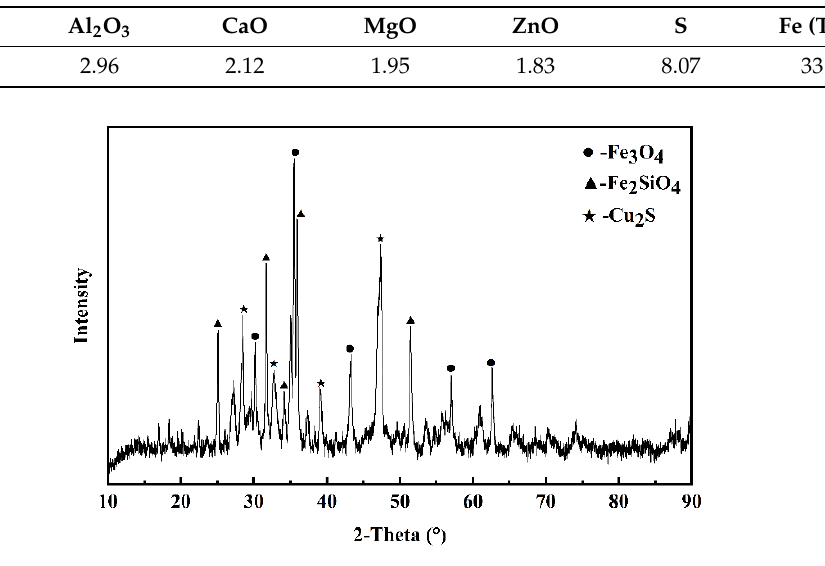
Table 1. Main components in CS (wt%).